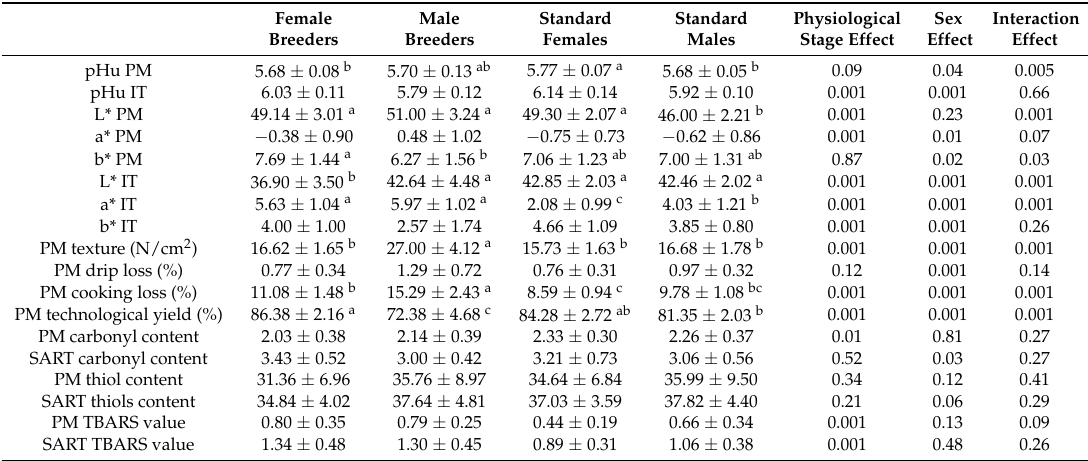
Table 2. Technological quality of meat from males and females of breeder and standard turkeys ( n = 20). Female